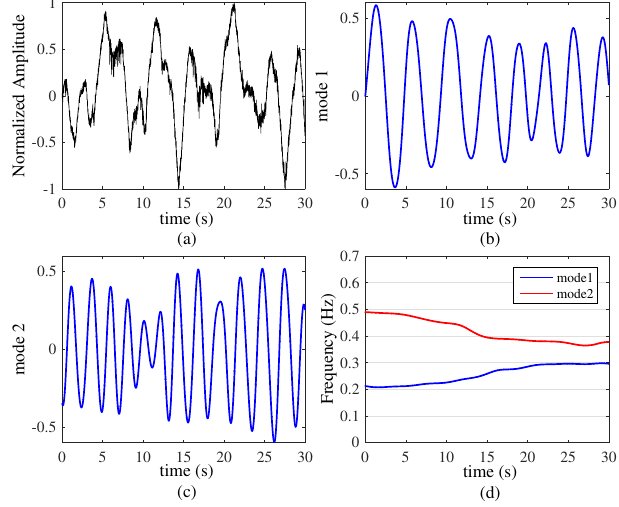
Figure 8. Two targets with time-varying respiration rates and VMD based algorithm results ( k = 3, α = 20,000). ( a ) Original signals; ( b ) and ( c ) two modes decompose by VMD based algorithm; ( d ) time-varying respiration